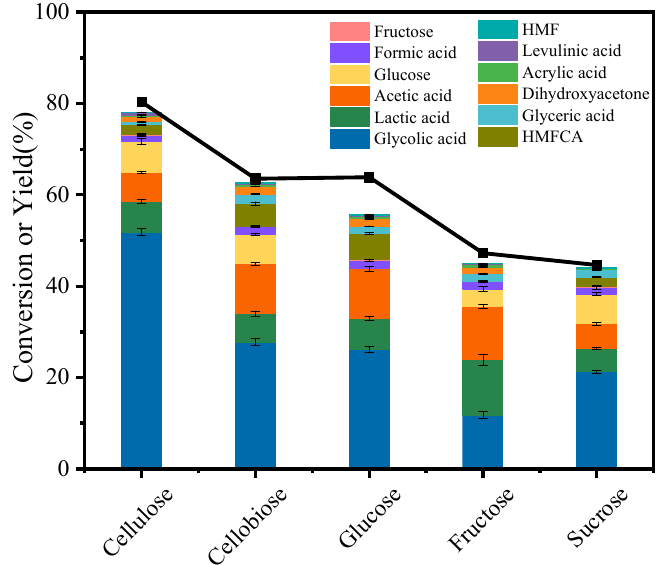
Figure 13. The effect of substrates on the catalytic activity of Bi/ β -2 catalysts. Reaction conditions: substrate 0.1 g, Bi/ β -2 0.08 g, H 2 O 12 mL, 180 °C, 10 h, 2 MPa O 2 .